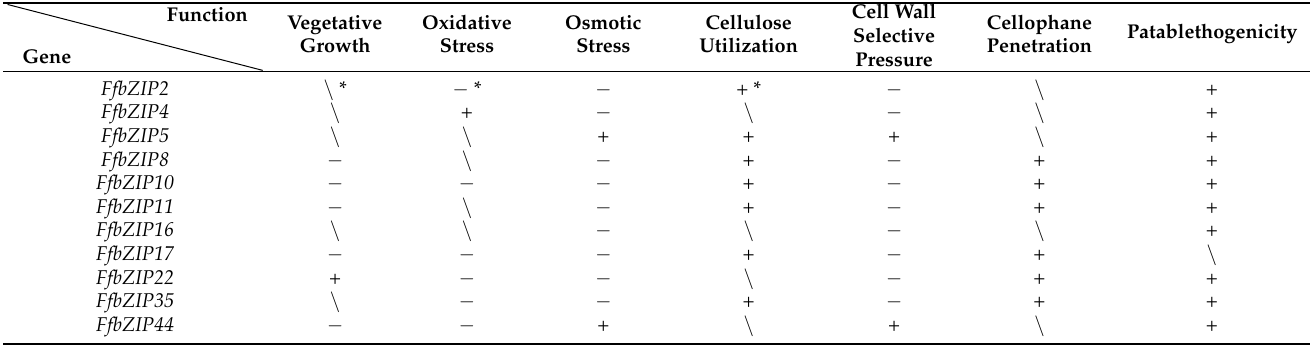
Table 3. The biological function and pathogenicity of FfbZIP